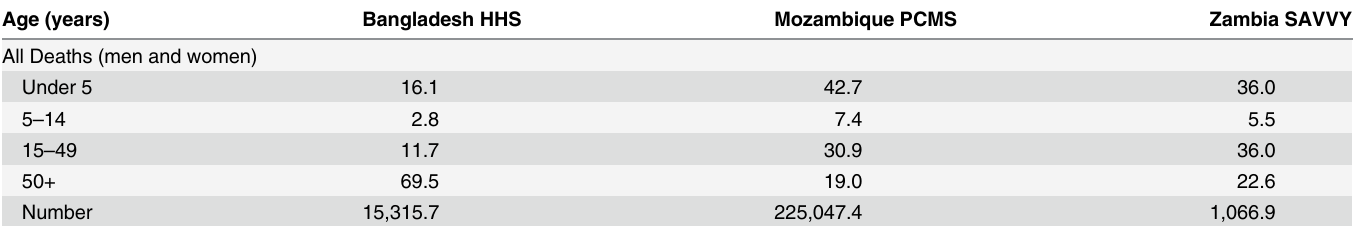
Table 4. Distribution of deaths by age group and country/platform, weighted Age (years)